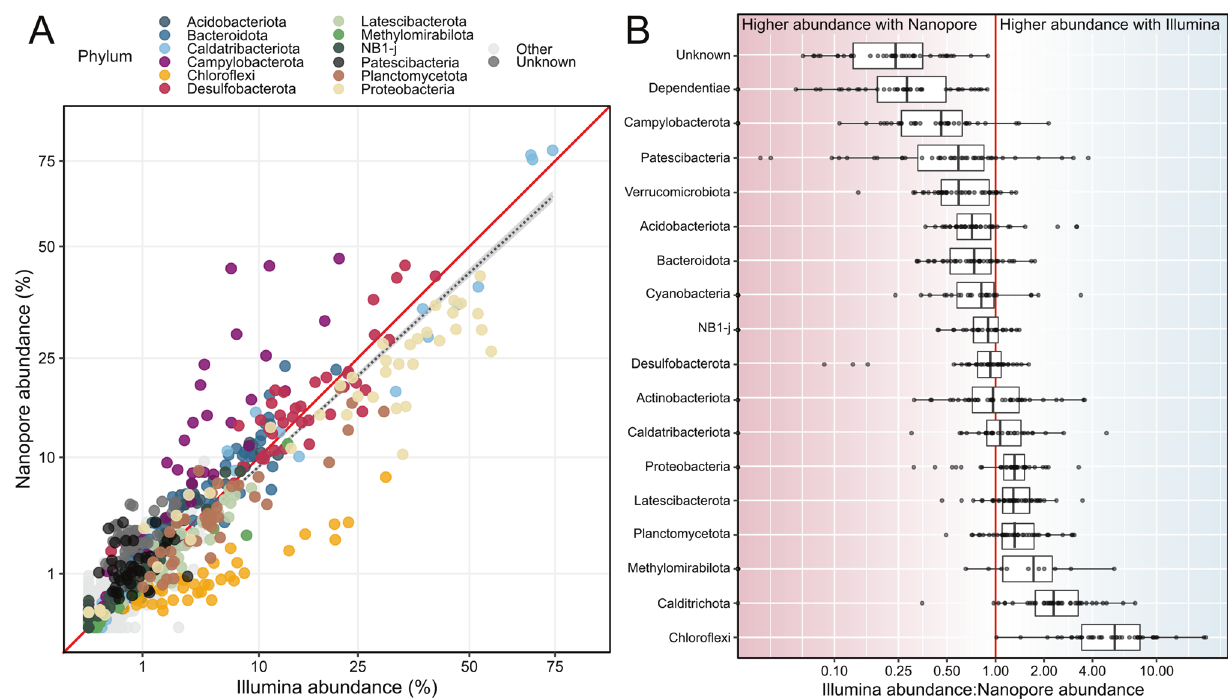
Fig. 4 Comparison of Nanopore and Illumina amplicon sequencing. A Correlation between abundance of phyla sequenced with Nanopore ( y -axis), and Illumina (x-axis) technology (Pearson ’ s r = 0.905). Abundant phyla are colored, “ Unknown ” represents the sequences not identi fi ed at the phylum level, and “ Other ” represents the less abundant phyla. The black dashed line shows the linear relationship between Nanopore and Illumina abundances, and the red line shows a 1:1 ratio. The axes have been square root transformed. B The ratio of Illumina abundance to Nanopore abundance of select phyla. Ratios for individual samples are overlaid on the boxplots. The red line shows a 1:1 ratio. The same comparisons at other taxonomic levels can be found in Figs. S1 – 3.